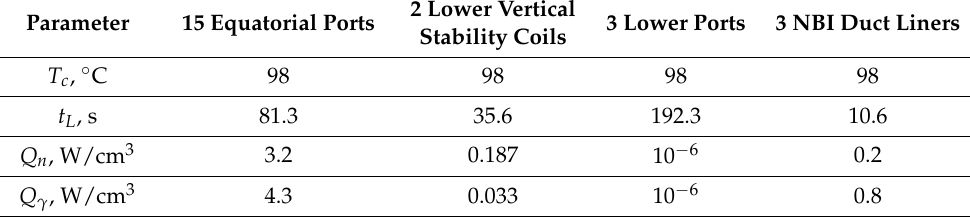
Table 22. Simulated thermohydraulic and energy deposition rate data for 15 Equatorial Ports (Module 7 contains 1 block), 2 Lower Vertical Stability Coils (Module 8 contains 1 block), 3 Lower Ports (Module 9 contains 1 block), and 3 NBI Duct Liners (Module 10 contains 1 block). Further details of these components are given in Refs.